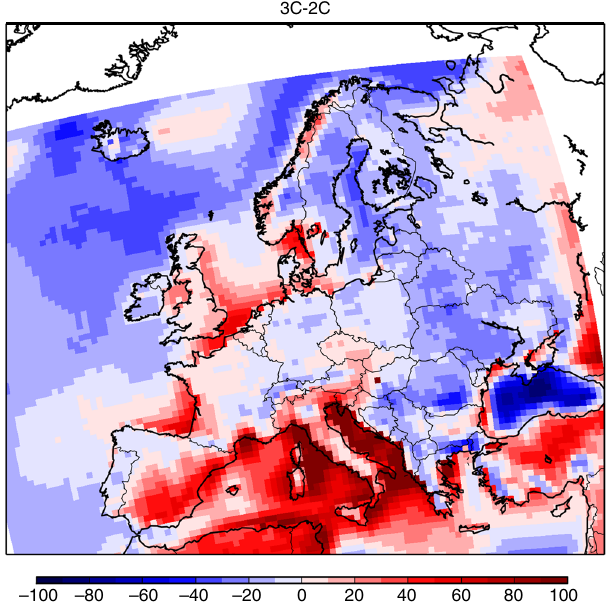
Fig. 6 Summer differences of 3C minus 2C for the mean number of hot days when daily maximum temperature is higher than 30 °C. The mean is calculated from the 30-year period of the different scenarios. This fi gure has been generated using the Matplotlib library for the Python programming language (https://matplotlib.org/)